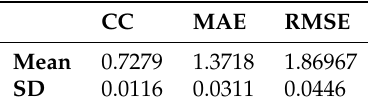
Table 11. Mean of evaluation results of the M5Rules model after five repetitions to predict the number of passed